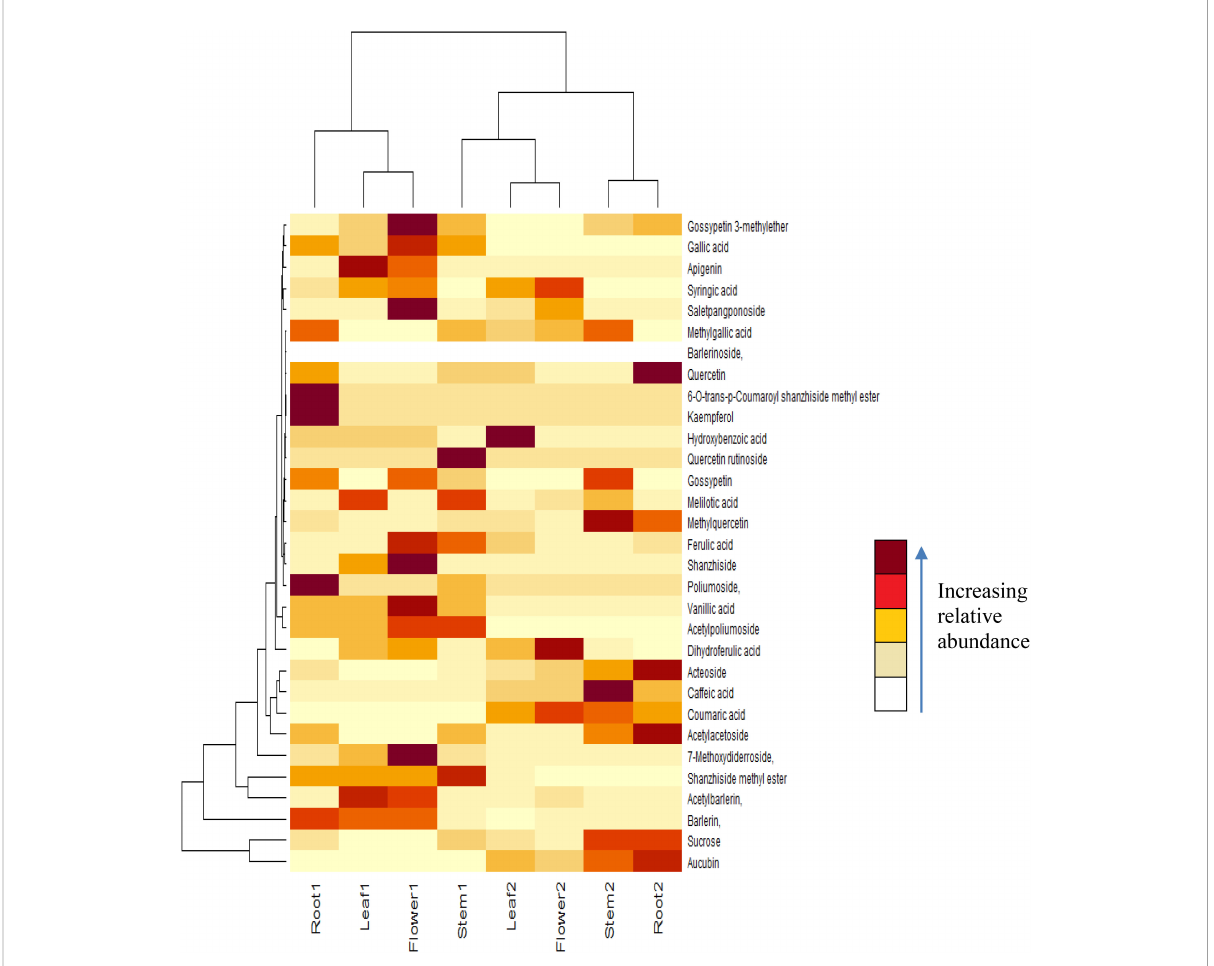
FIGURE 1 Heat map of compounds identi fi ed in different parts of B prionitis and B cristata . Root 1, Leaf 1, Flower 1 and Stem 1 are parts of B prionitis , whereas Leaf 2, Stem 2, Flower 2 and Root 2 are parts of B cristata